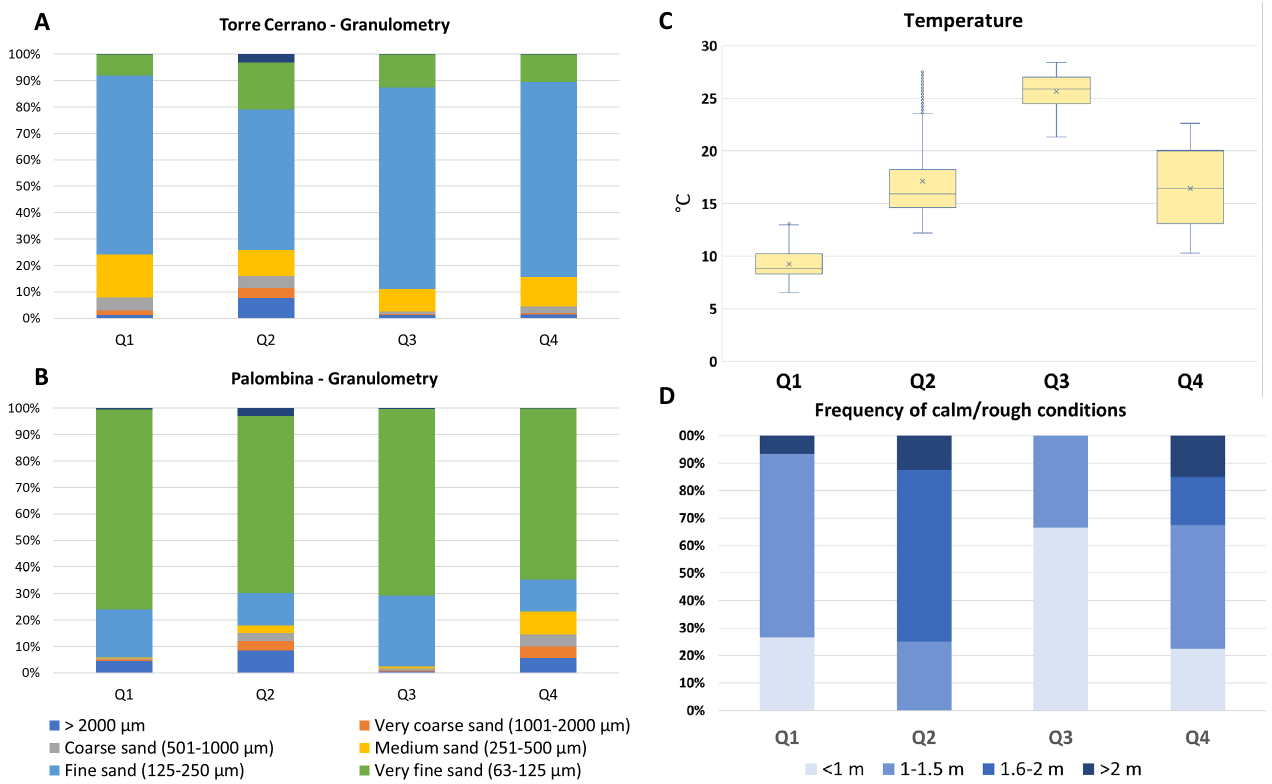
Figure 6. Environmental parameters. ( A , B ). Granulometric classes of sediments collected in Torre Cerrano MPA ( A ) and Palombina ( B ). ( C ). Temporal variations in superficial sea temperature. ( D ). Frequency of calm/rough sea conditions in the Adriatic Sea on the base of maximal wave height (m) recorded for each quarter (data source: [56–58]).